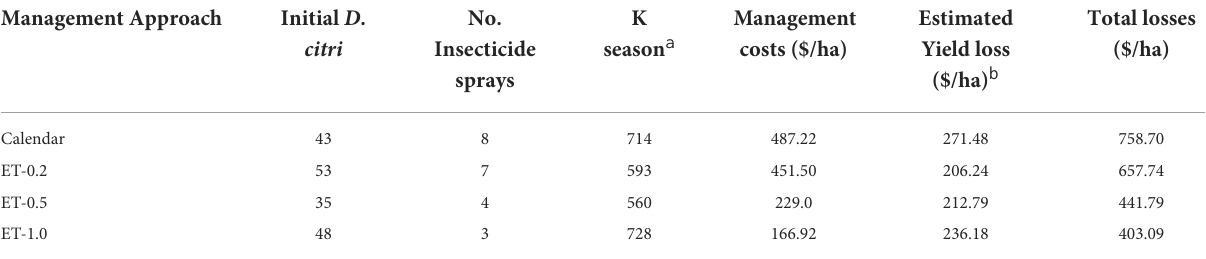
TABLE 5 Estimated management costs ($/ha) and yield losses ($/ha) associated with the presence of Diaphorina citri in Florida citrus. Management